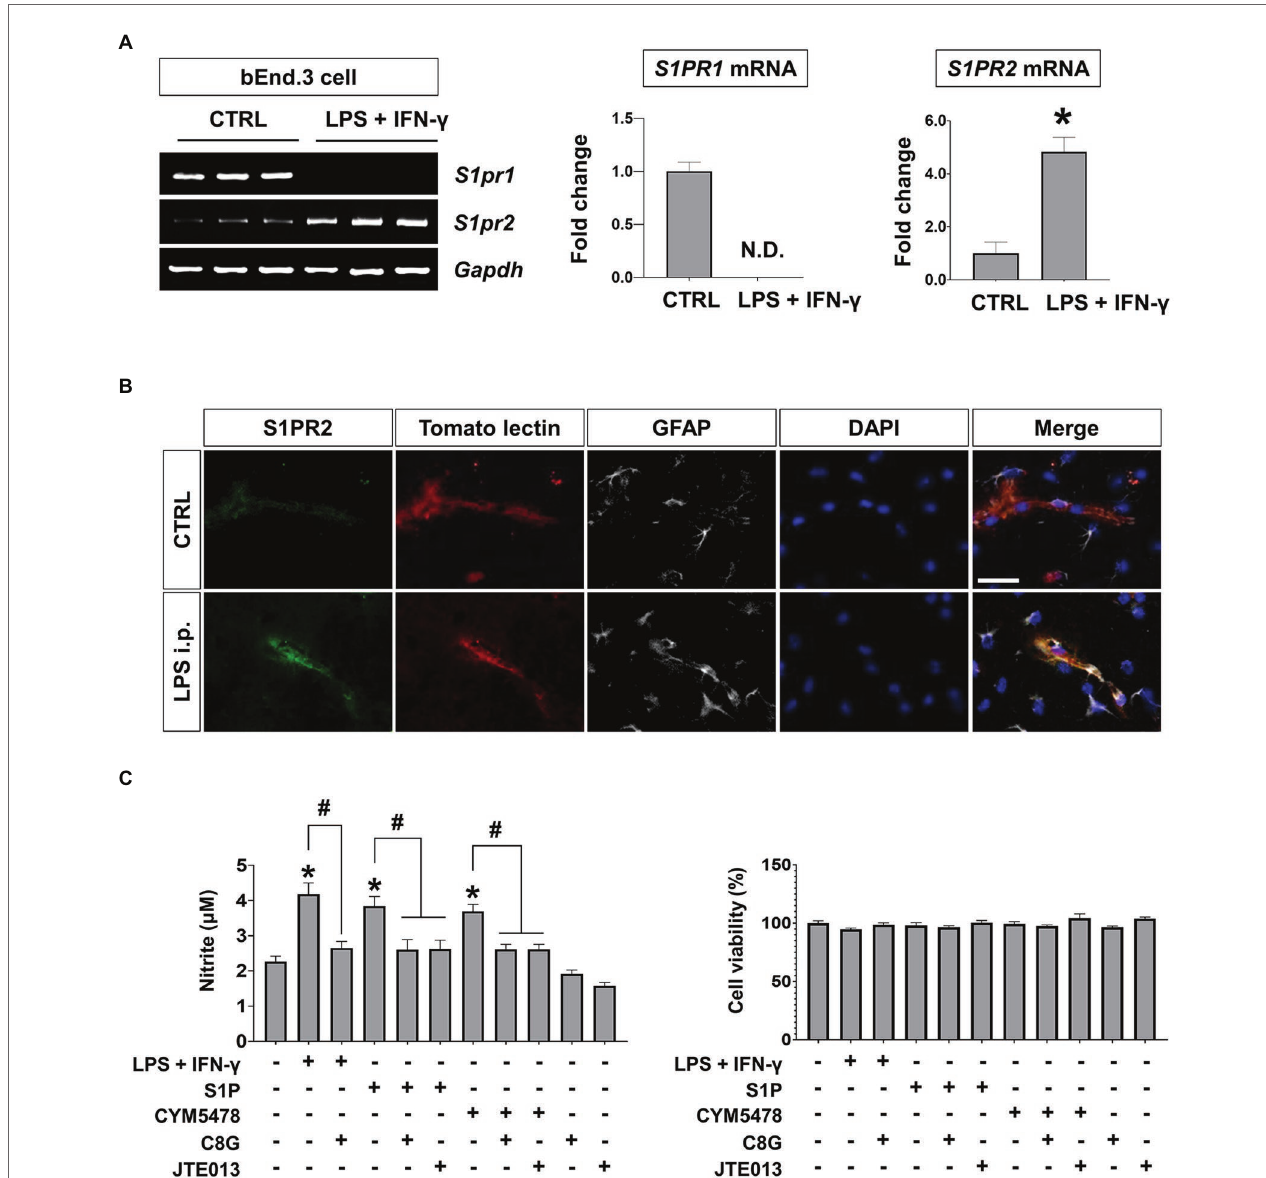
FIGURE 3 | S1PR2 induction and inhibitory effect of C8G on nitric oxide production in endothelial cells (ECs) under inflammatory conditions. (A) S1PR1 and S1PR2 expression in ECs after inflammatory stimulation. bEnd.3 cells were stimulated with LPS (1 μ g/ml) and IFN- γ (50 U/ml) for 6 h, followed by the extraction of total RNA. Alterations in S1PR1 and S1PR2 mRNA expression were analyzed by RT-PCR ( n = 3). CTRL, control. (B) Immunofluorescence analysis of S1PR2 in the hippocampus. Mice were injected with LPS (5 mg/kg) intraperitoneally (i.p.). Tomato lectin stains brain blood vessels (red). An anti-GFAP antibody was used as a marker of astrocytes (gray). Scale bar, 25 μ m. (C) C8G inhibited nitric oxide production in bEnd.3 cells. bEnd.3 cells were stimulated with LPS (1 μ g/ml) + IFN- γ (50 U/ml), sphingosine-1-phosphate (S1P; 1 μ M), or CYM5478 (1 μ M) for 24 h after a 2 h pretreatment with C8G (1 μ g/ml) or JTE013 (1 μ M; n = 3). Data are the mean ± SEM. * p < 0.05 vs. the control, # p < 0.05, Student’s t -test (A) or Tukey’s multiple comparisons test after one-way ANOVA (C)